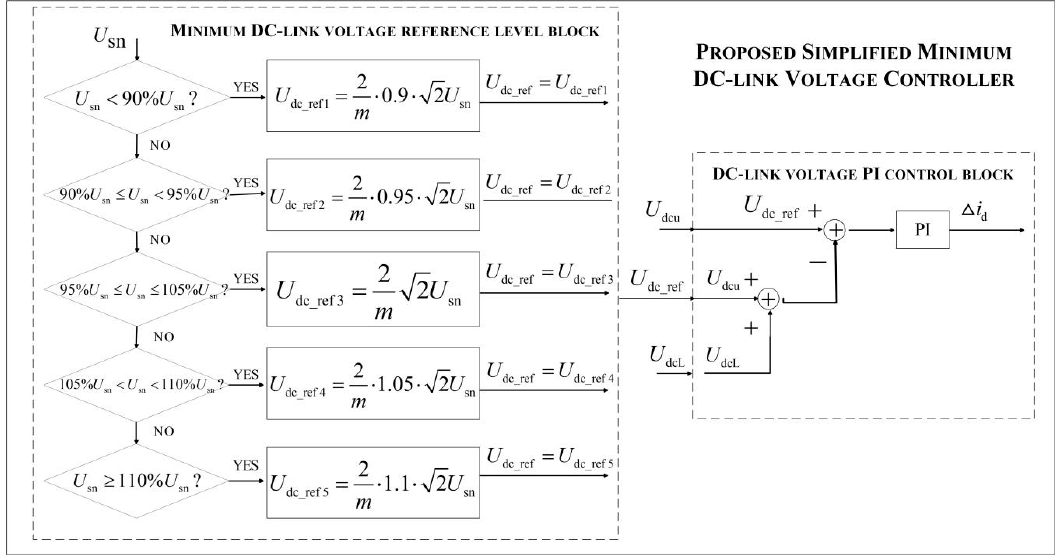
Figure 3. The control block of proposed simplified minimum DC-link voltage control strategy.